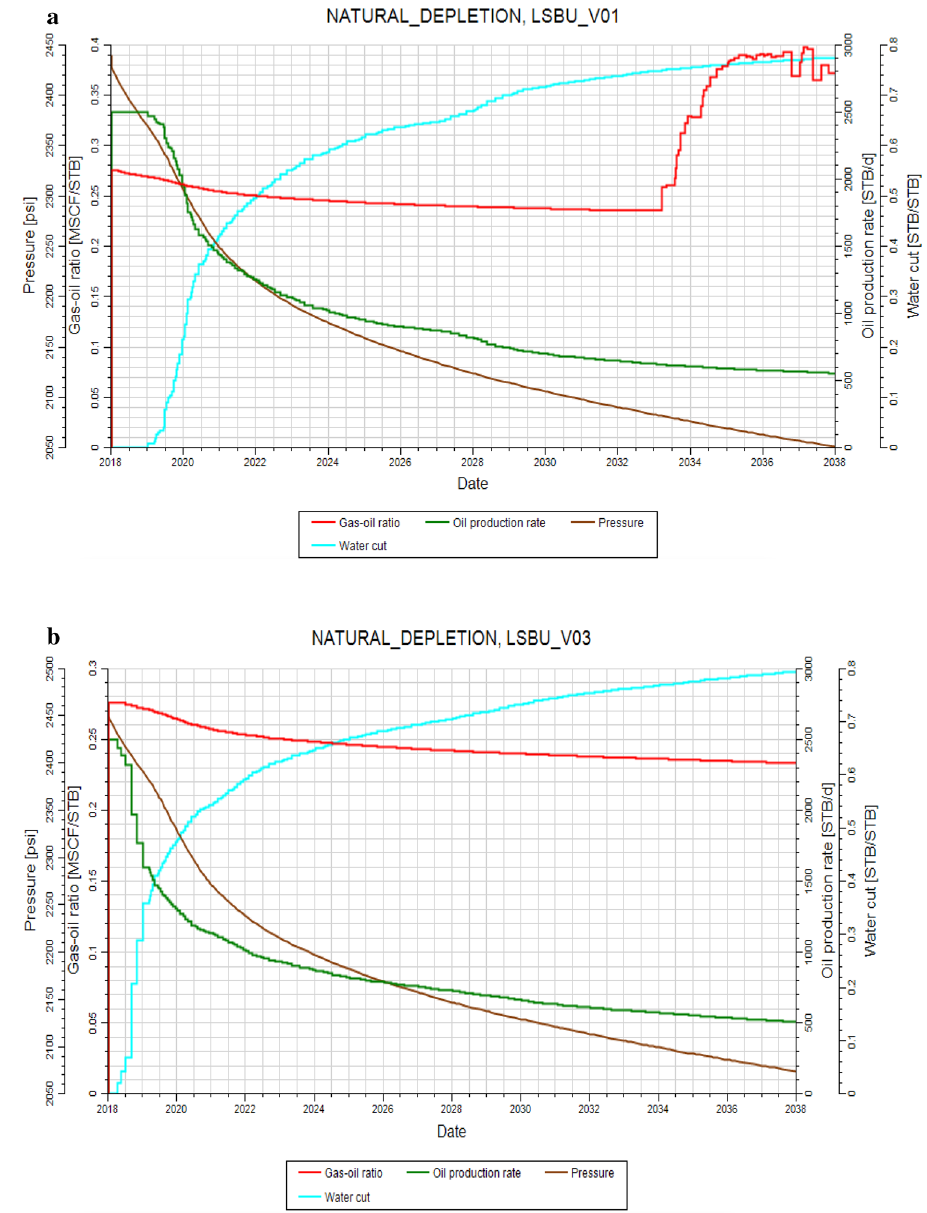
Fig. 9 a Well production perfor- mance plot at natural